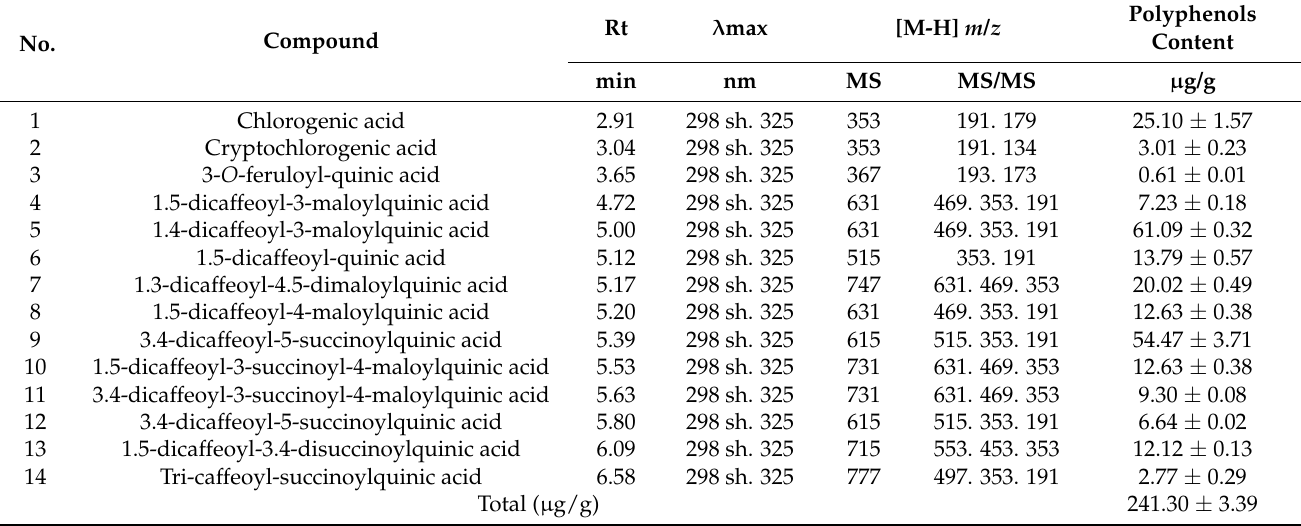
Table 1. Individual and total phenolic compounds identified by UPLC-PDA-MS/MS in the botanical biogranulate (average ±